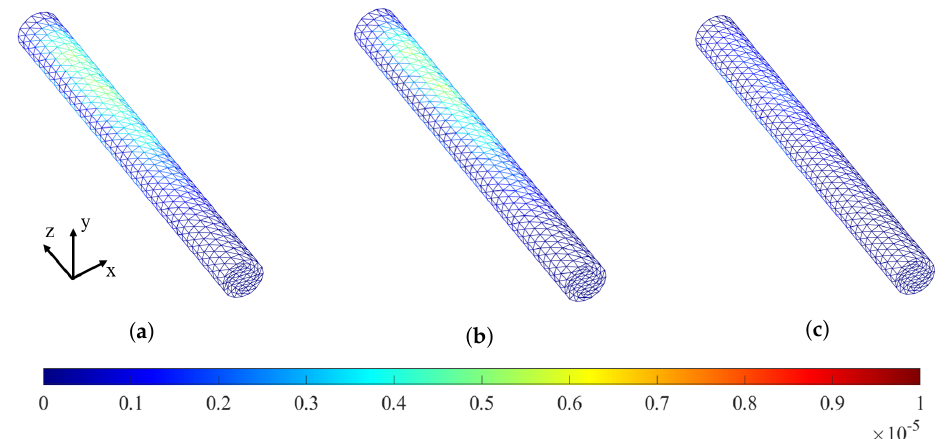
Figure 10. The error contour of the von Mises strain of the different error tolerance e i = 10%, 1%, and 0.1% for t = 6.8 s. ( a ) e i = 10%; ( b ) e i = 1%; ( c ) e i = 0.1%.